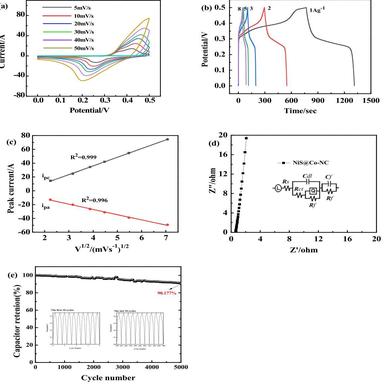
(a) CV curves of NiS @Co-NC at different scan rates; (b) GCD curves of NiS@Co-NC at different current densities; (c) ip-ν1/2 plots of the NiS @Co-NC electrode material; (d) Nyquist plots and equivalent circuit diagram; (e) cyclic performance for the NiS @Co-NC electrode material at a current of 10 A⋅g− 1 .